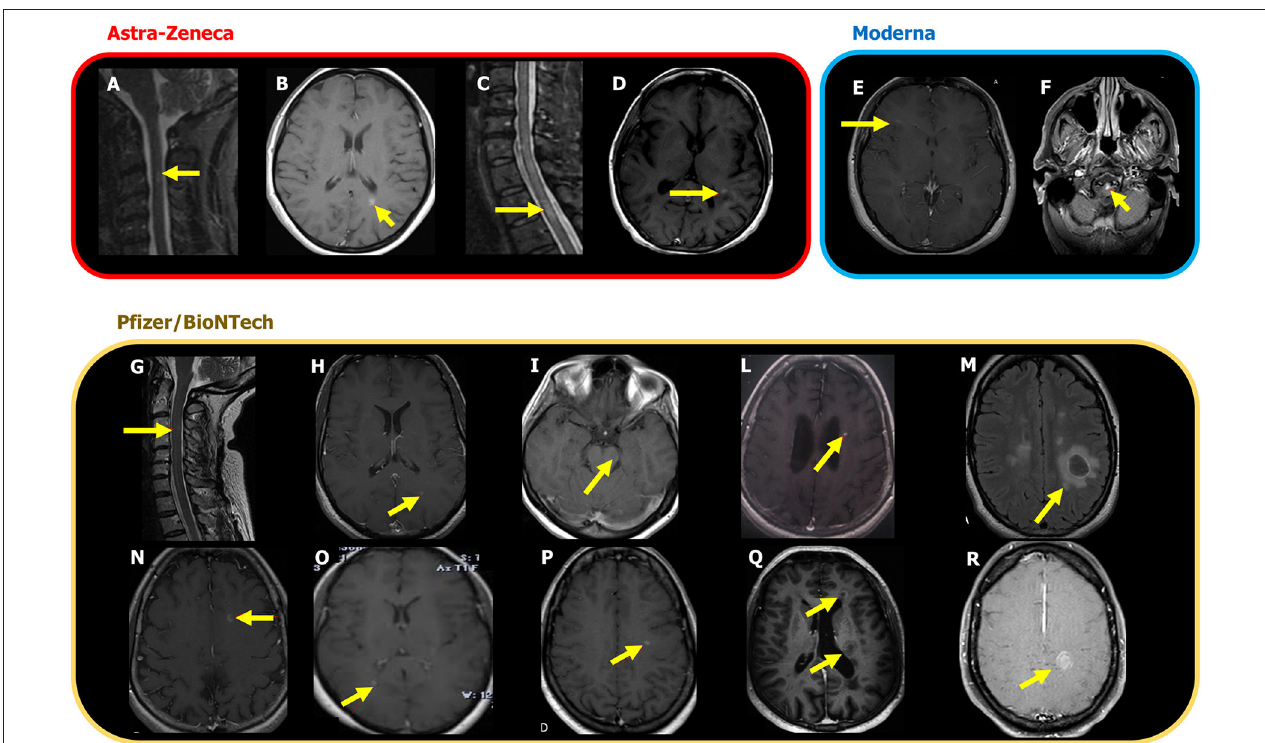
FIGURE 1 | New MRI lesions associated with the MS episodes occurred after ChAdOx1 nCoV-19 (AZD12222), mRNA-1273, Moderna and BNT162b2, Pfizer/BioNTech vaccine. The lesions are shown on T2 weighted images or on post-contrast T1 weighted images and are indicated by yellow arrows. (A) Case 1: C3 lesion; (B) Case 2: new enhancing lesion in corpus callosum and multiple white matter unenhanced lesions in periventricular areas and in the mesial occipital lobe; (C) Case 3: new enhancing lesion in the thoracic cord; (D) Case 4: multiple hyperintense lesions in the supra and infratentorial white matter, four of which are with